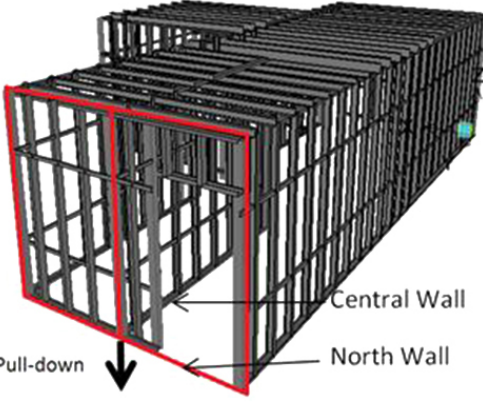
Figure 2. North Wall at the experimental test.